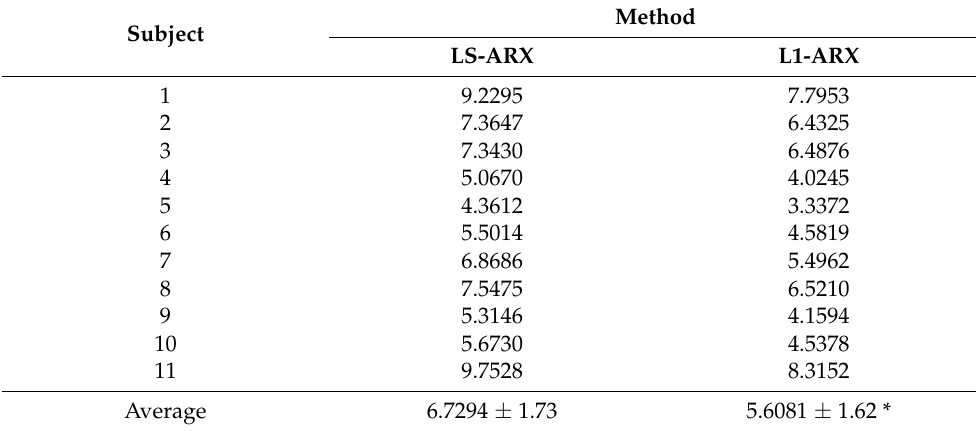
Figure 4. The predicted results of the model. The red curve is the desired system output, the green curve is the predicted output by L1-ARX, and the blue curve represents the output predicted by LS-ARX. For the convenience of display, we only draw the prediction results for a certain period of time. Table 9. The error ( µ v) of the predicted signal with the two ARX